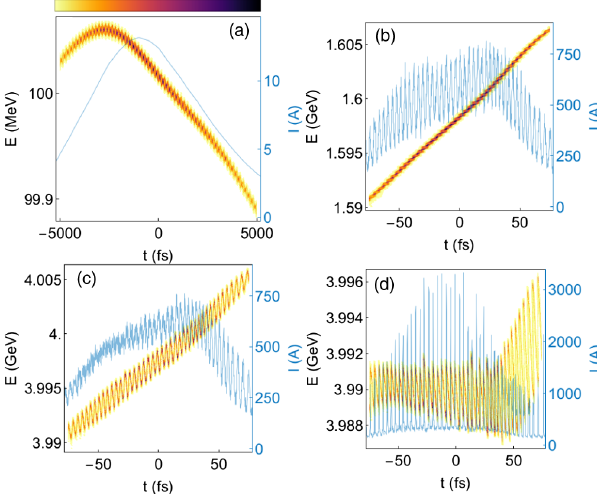
FIG. 8. Generation of highly periodic bunch train at the LCLS-II scS beamline. Longitudinal phase space: (a) after the laser heater, (b) after BC2, (c) after the dogleg, and (d) at the center of the soft x-ray undulator entrance. The colorbar above (a) shows the relative density for each plot. See Table IV.